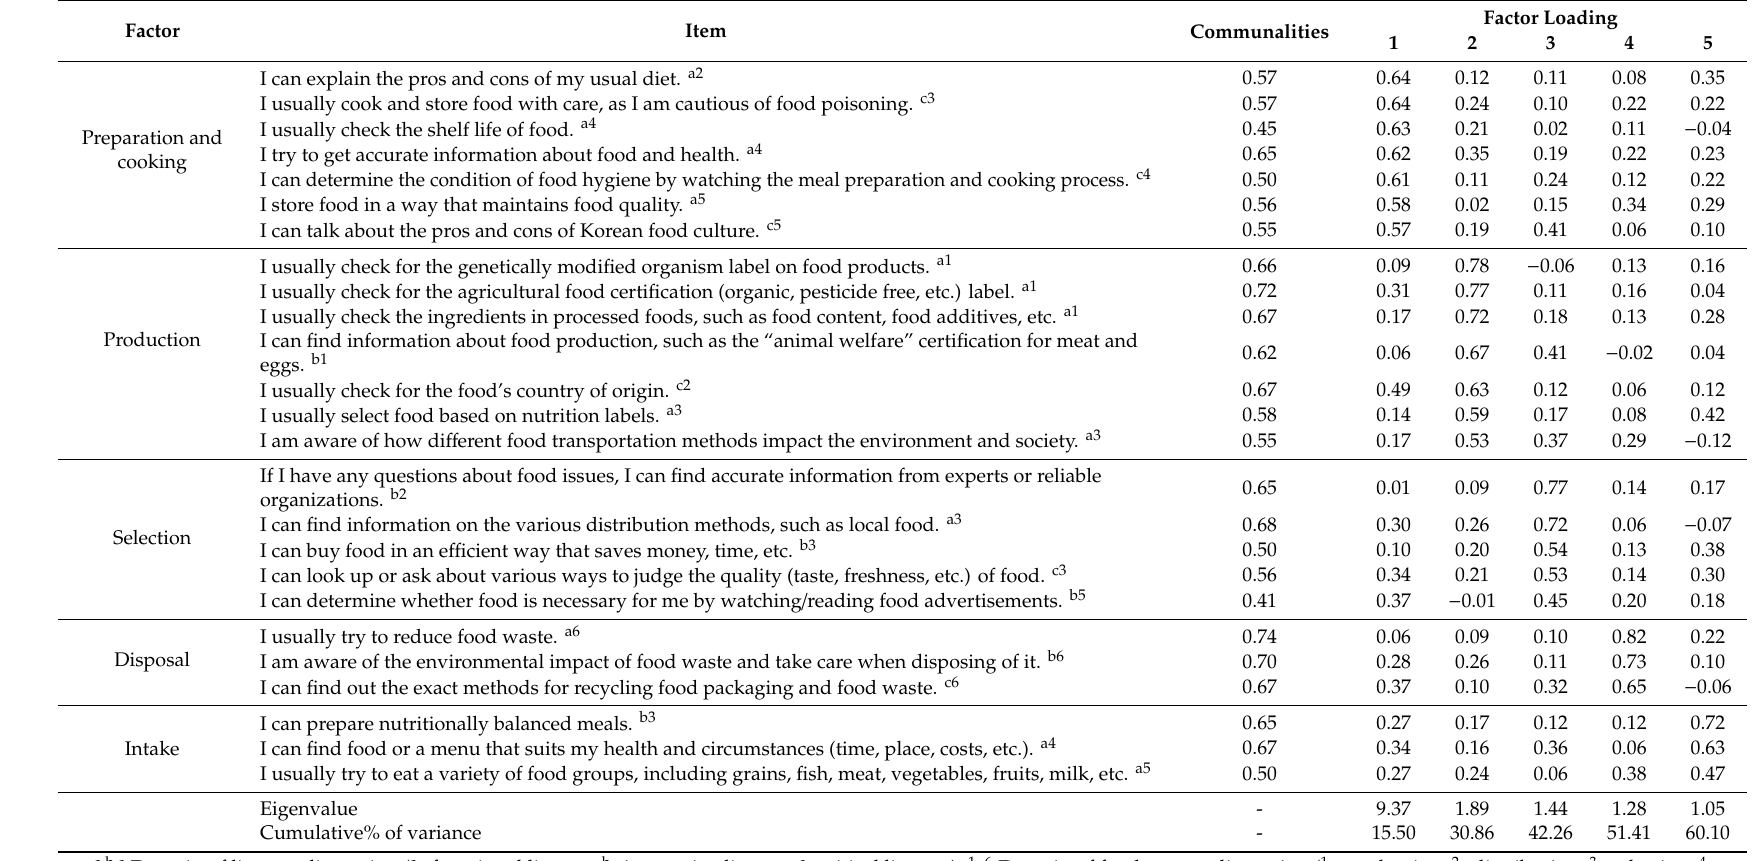
Table 5. Results of the exploratory factor analysis on the final questionnaire ( n =